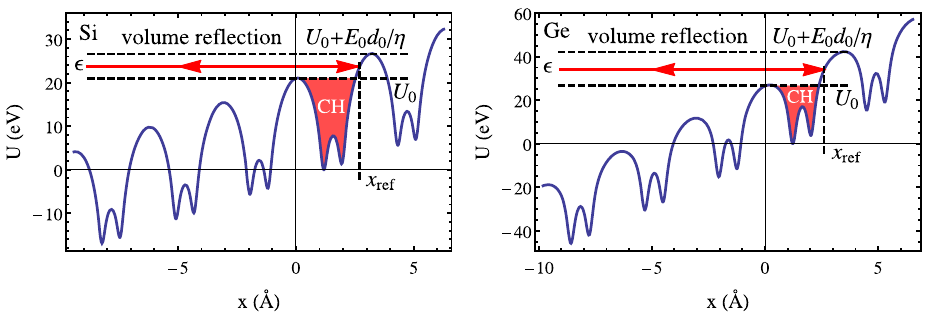
Fig. 1 Interplanar potential of (111) Si and Ge crystals for maximal bending radii (4.76 cm and 1.83 cm respectively) used in the